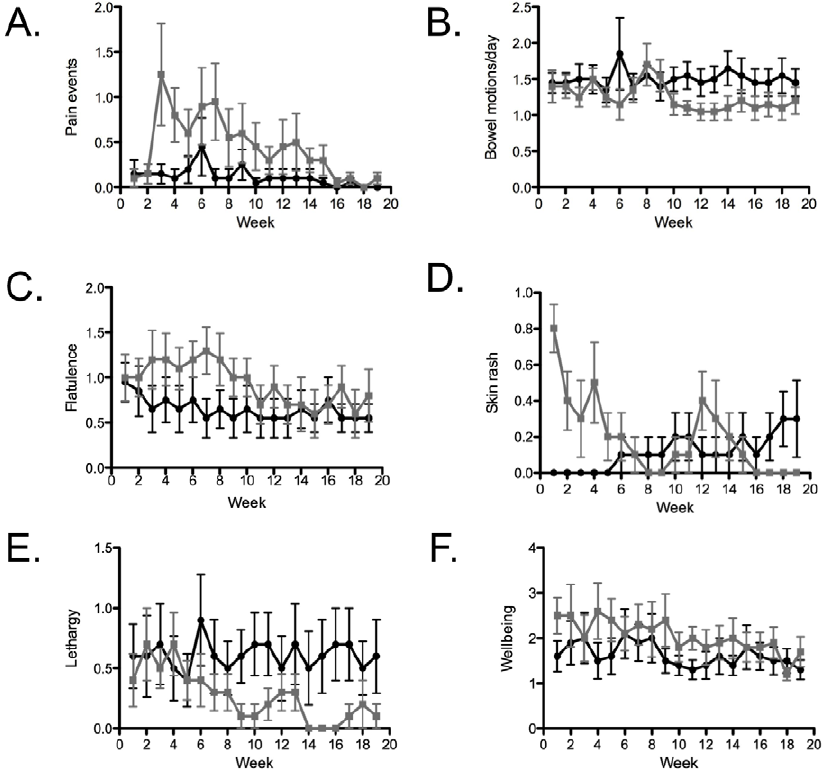
Figure 4. Symptom responses to hookworm infection. Control group is indicated by black circles, hookworm group by grey squares, values are mean + / 2 SEM. (A) pain events, (B) bowel motions/day, (C) flatulence, (D) skin rash, (E) lethargy, (F) wellbeing. Area under the curve analysis followed by Mann-Whitney U test to compare between groups showed that pain events (A) was significantly different between the groups.